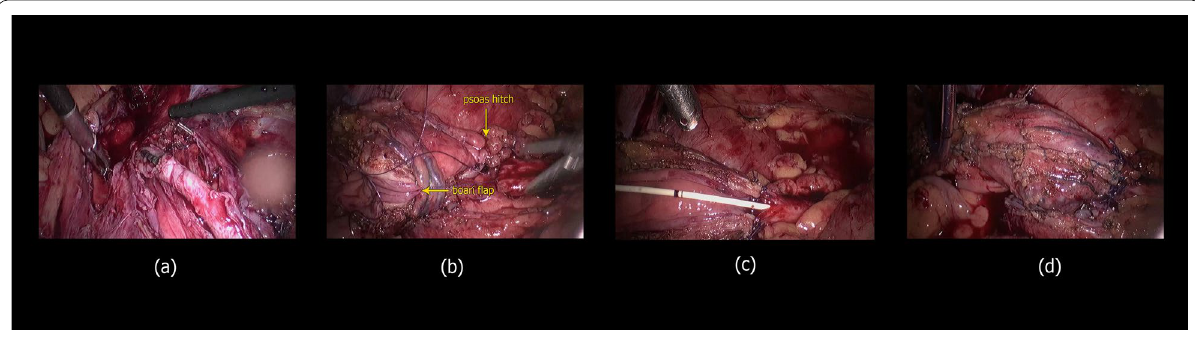
Fig. 2 a Dense right periureteral adhesions resulting in partial transection of ureter during attempted ureterolysis. b Boari flap with psoas hitch. c After performing posterior layer of boari flap ureteroneocystostomy. d After completion of boari flap